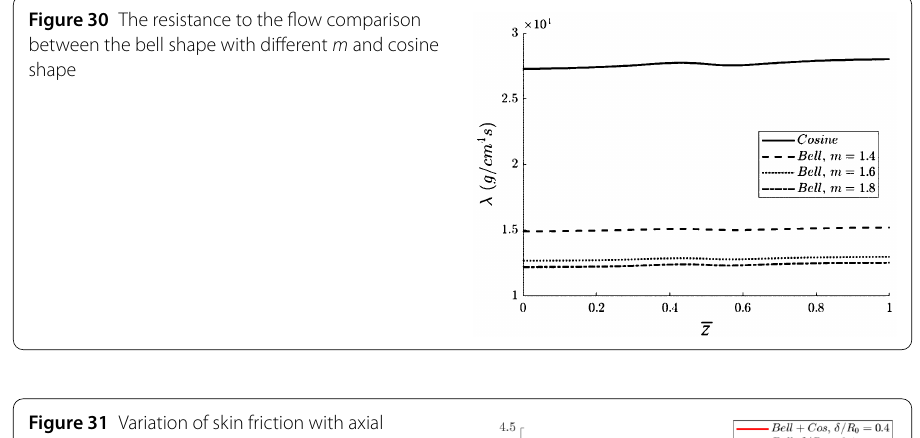
Figure 31 Variation of skin friction with axial distance for different stenosis heights in bell shape and combined shape of bell and cosine stenosis